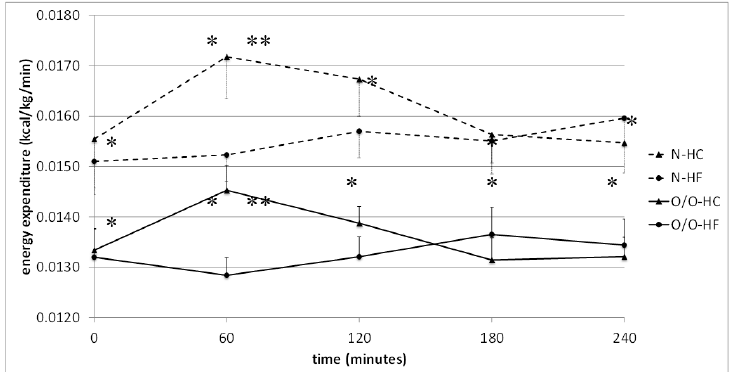
Figure 3. Energy expenditure (kcal/kg/min) in people with normal body weight (N, the broken line) and overweight/obese people (O/O, the solid line) in fasting state (time 0 min) and after consumption (time 60–240 min) of a high-carbohydrate meal (HC) and a high-fat meal (HF). The results are presented as mean values ± SE. The comparison between study groups N and O/O * p < 0.05; the comparison between meals HC and HF ** p < 0.05.